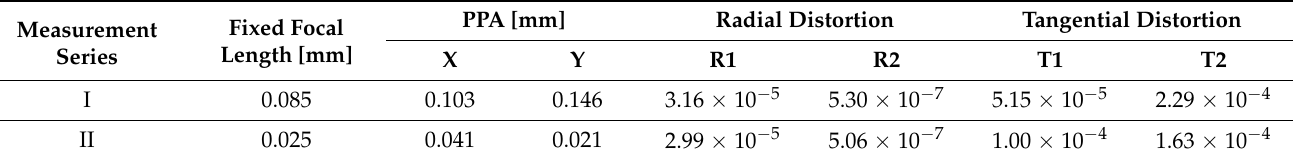
Table 9. Standard deviations for the results of specific methods of thermogram sharpness enhance- ment.